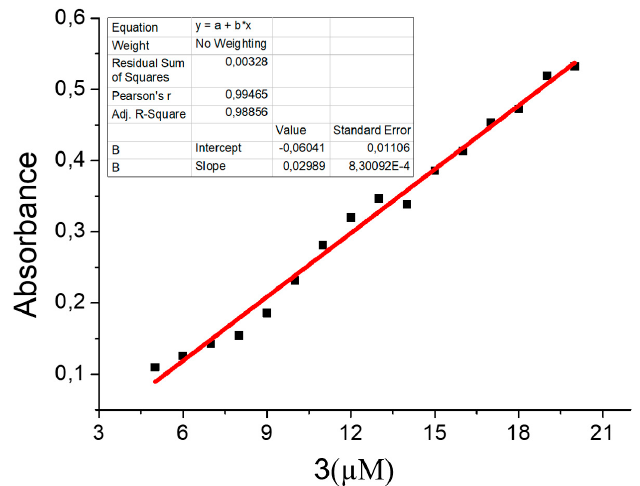
Figure 10. Calibration curve for coumarin concentration.